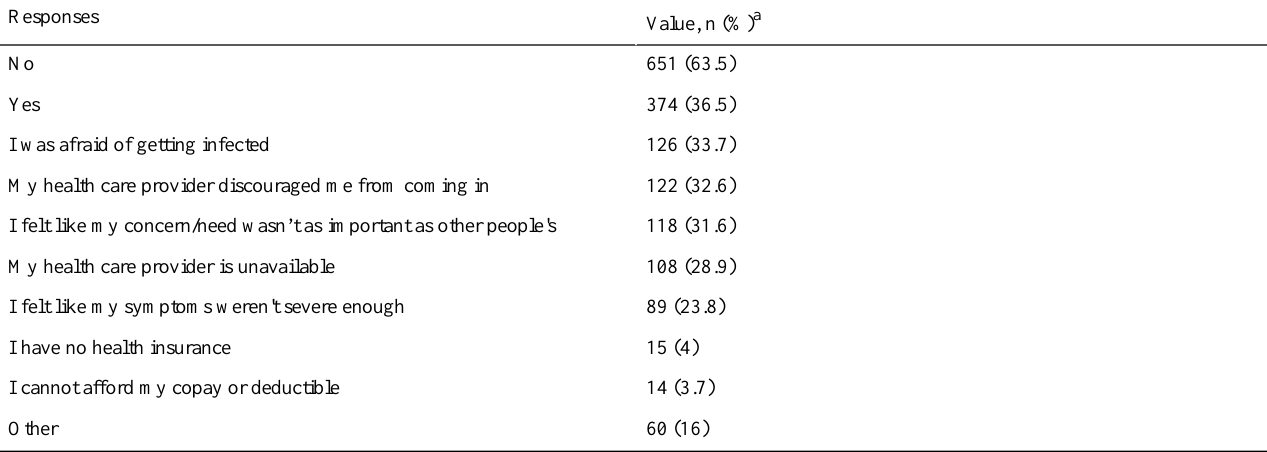
Table 2. Barriers to receiving health care during the COVID-19 pandemic (n=1025). Responses to the following question are presented: “Since the start of the coronavirus pandemic, have you needed to get healthcare but haven't gotten it?